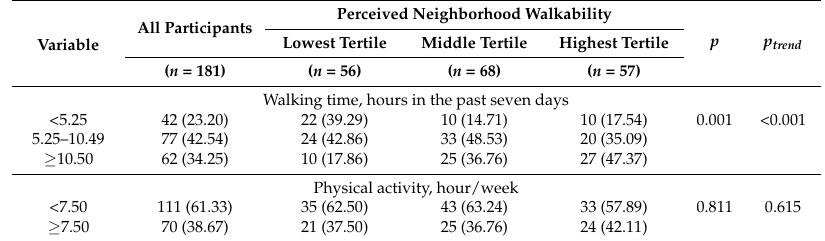
Table 3. Walking time and physical activity according to tertiles of perceived neighborhood walkability * ( n = 181).